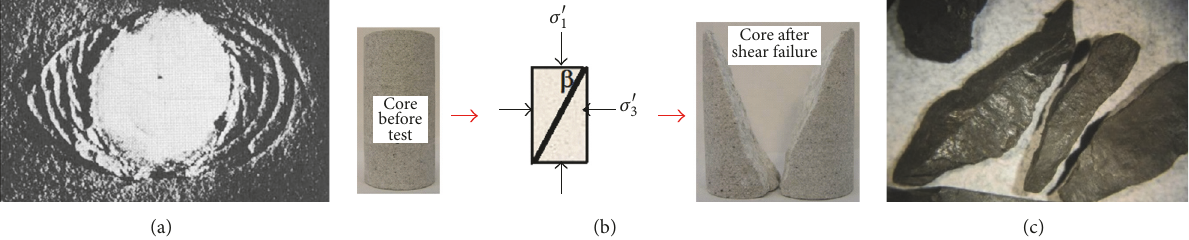
Figure 10: Angular or splintered cavings caused by shear failures: a case of lower mud weight than the shear failure gradient. (a) Borehole breakout from shear failure in a laboratory test [25]; (b) triaxial compressive core test creating angular rock pieces; (c) angular/splintered cavings from a subsalt